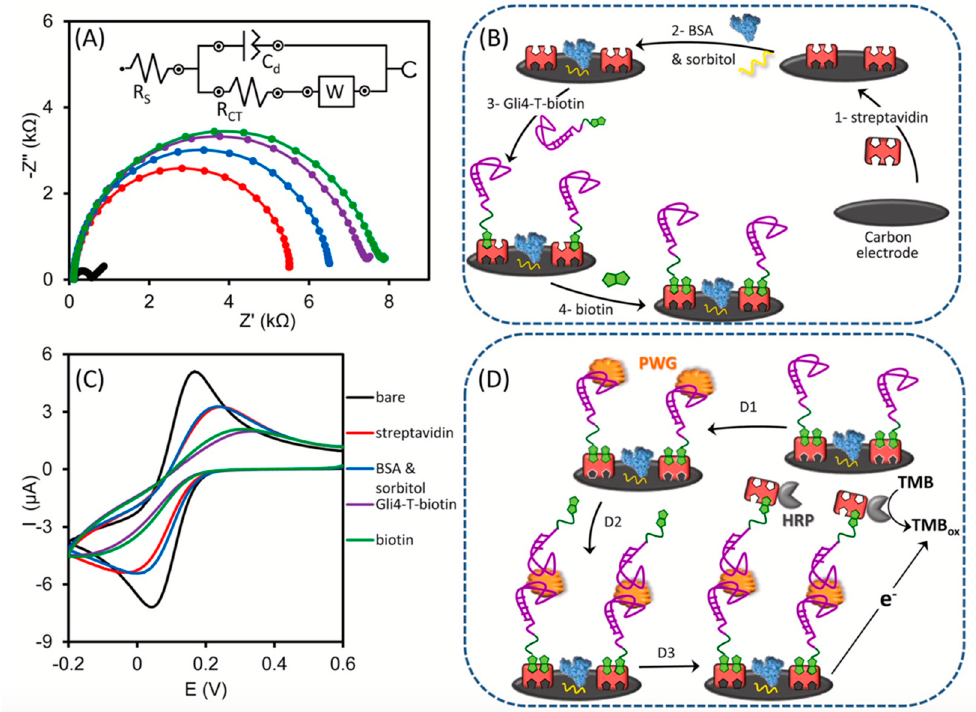
Figure 9. Sandwich biosensor based on a truncated aptamer capable of recognizing gliadin directly in a DES: ( A ) Nyquist plots of 0.5 mM [Fe(CN) 6 ] 3 − /4 − after each modification step involved in the assembly of the biosensor, which are schematically represented in ( B ). ( C ) Voltammetric measurements recorded in KCl 0.1 M with 0.5 mM [Fe(CN) 6 ] 3 − after each modification step. ( D ) Steps involved in the sandwich assay; D1: interaction with the sample containing gliadin, D2: incubation with the second aptamer labelled with biotin, D3: incubation with streptavidin–HRP conjugate and chronoamperometric measurement of the oxidized tetramethylbenzidine enzymatically produced. (Reprinted with permission from [69].)